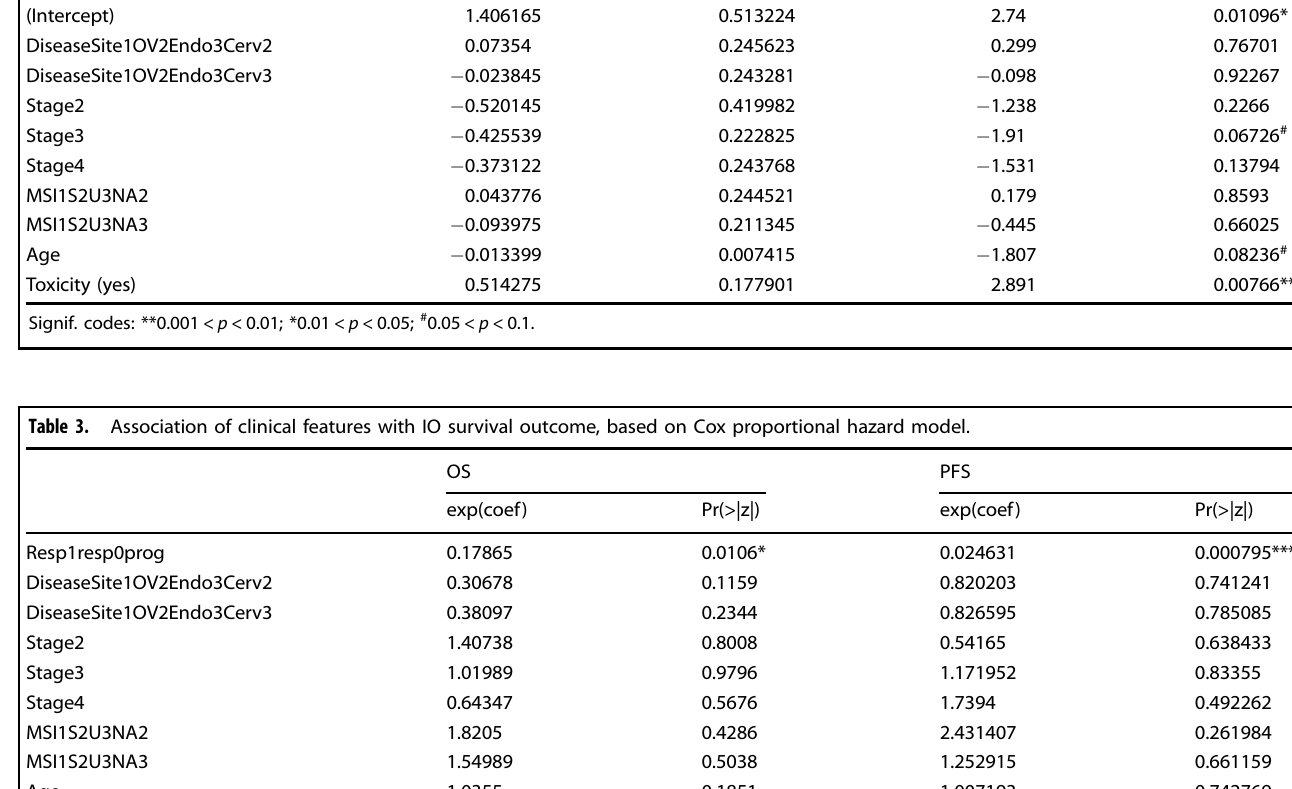
Table 2. Association of clinical features with IO response outcome, based on general linear regression model. Estimate